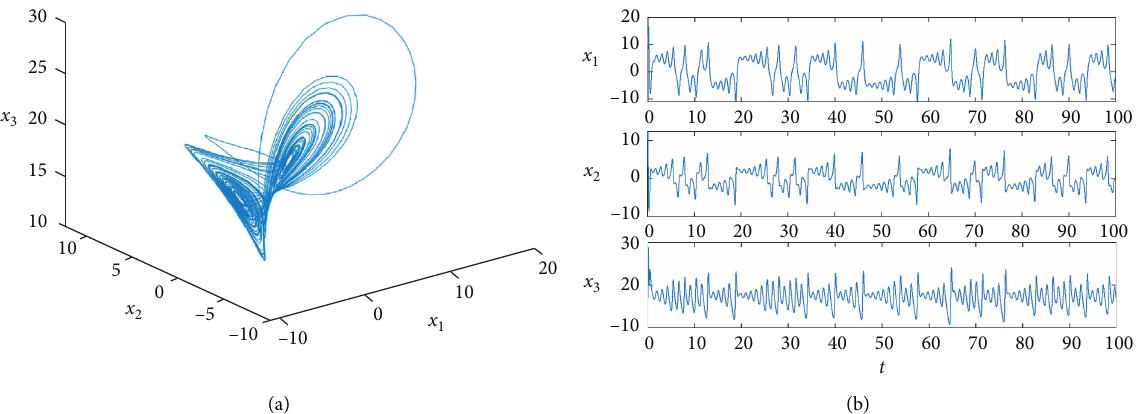
,x , x ) T � ( 10 , 10 , 10 ) T . (a) 3D phase portraits. (b) Time 1 2 3